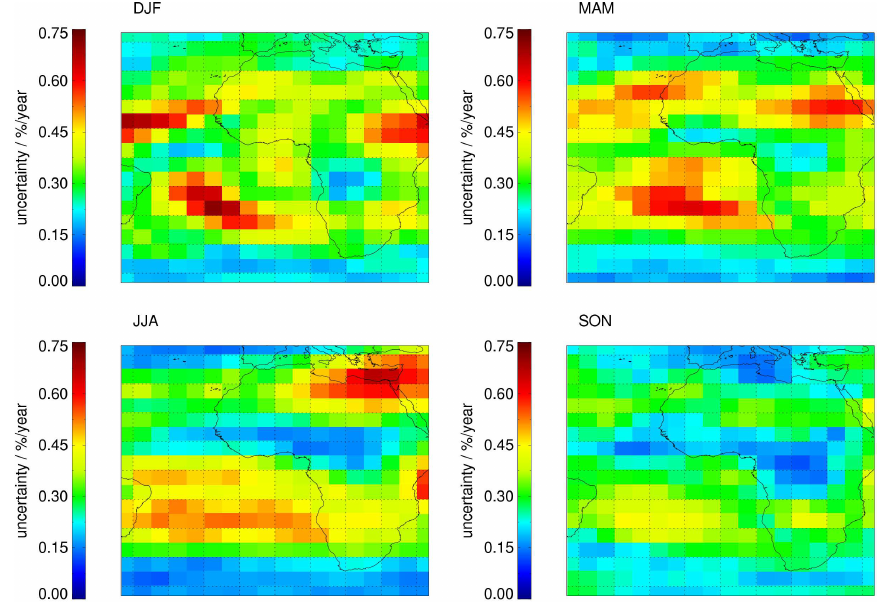
Figure 11. Same as Fig. 10 but for the uncertainty of the linear trend in relative FTH. 2